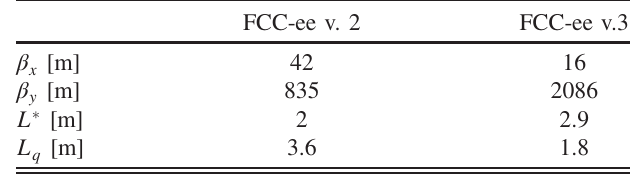
TABLE VI. The changes between FCC-ee versions 2 and 3.